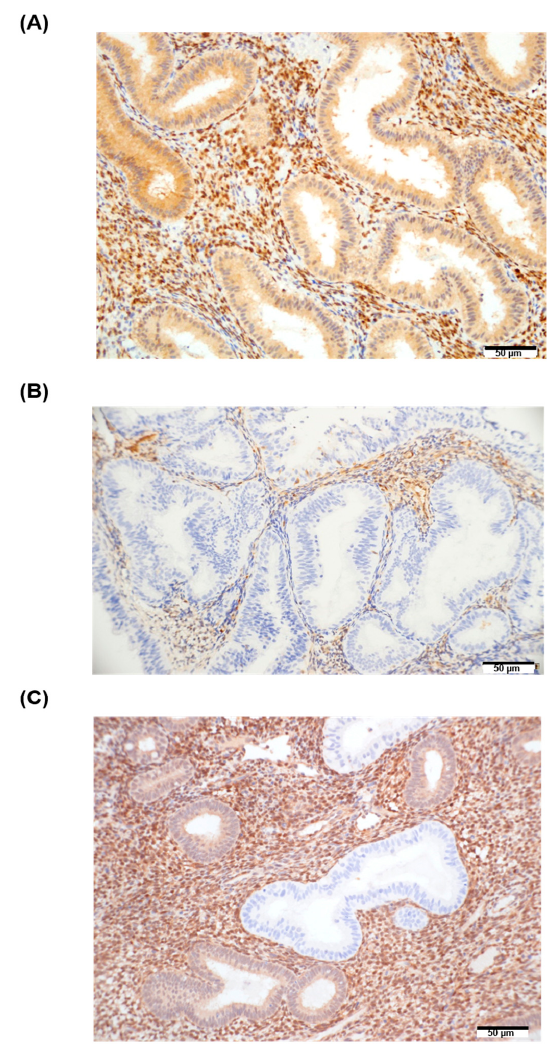
Figure 4. Degree of PTEN loss in endometrial hyperplasia without atypia: ( A ) Expression of PTEN in the cytoplasm of endometrial glandular epithelium. Control sample of simple hyperplasia (SH-C1); cancer did not develop subsequently. ( B ) Endometrial hyperplasia without atypia that preceded to EC (SH-06P); complete PTEN loss was observed. ( C ) Sample of endometrial hyperplasia without atypia (SH-C52); PTEN expression is heterogeneous. The positive staining in the cytoplasm of the endometrial stromal cells served as an internal positive control. Table 2. PTEN IHC stain results of EH tissue in case and control patients with SH/CH-nonA and EC tissue in case